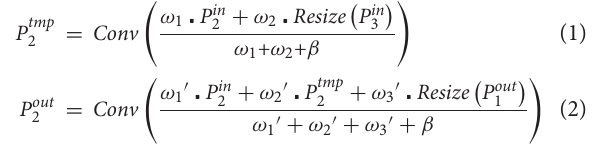
Figure 8 . The residual blocks are stacked in the trunk